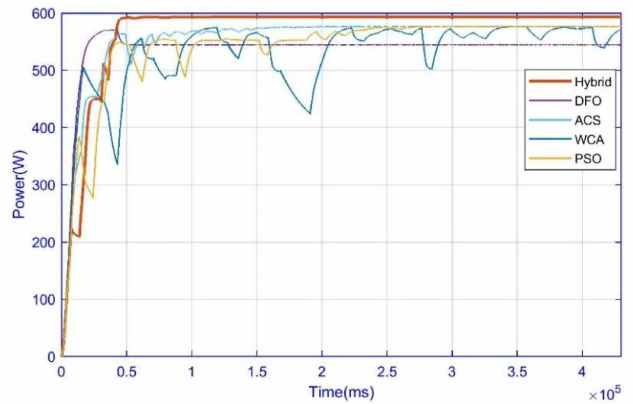
Figure 13. Case 3: Power comparison of hybrid with other techniques.